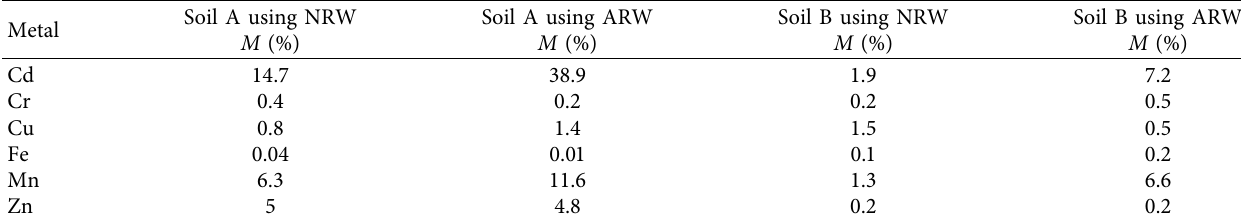
Table 3: Percentage of metals leached under diferent rainwater conditions. Soil A using NRW Soil A using Metal